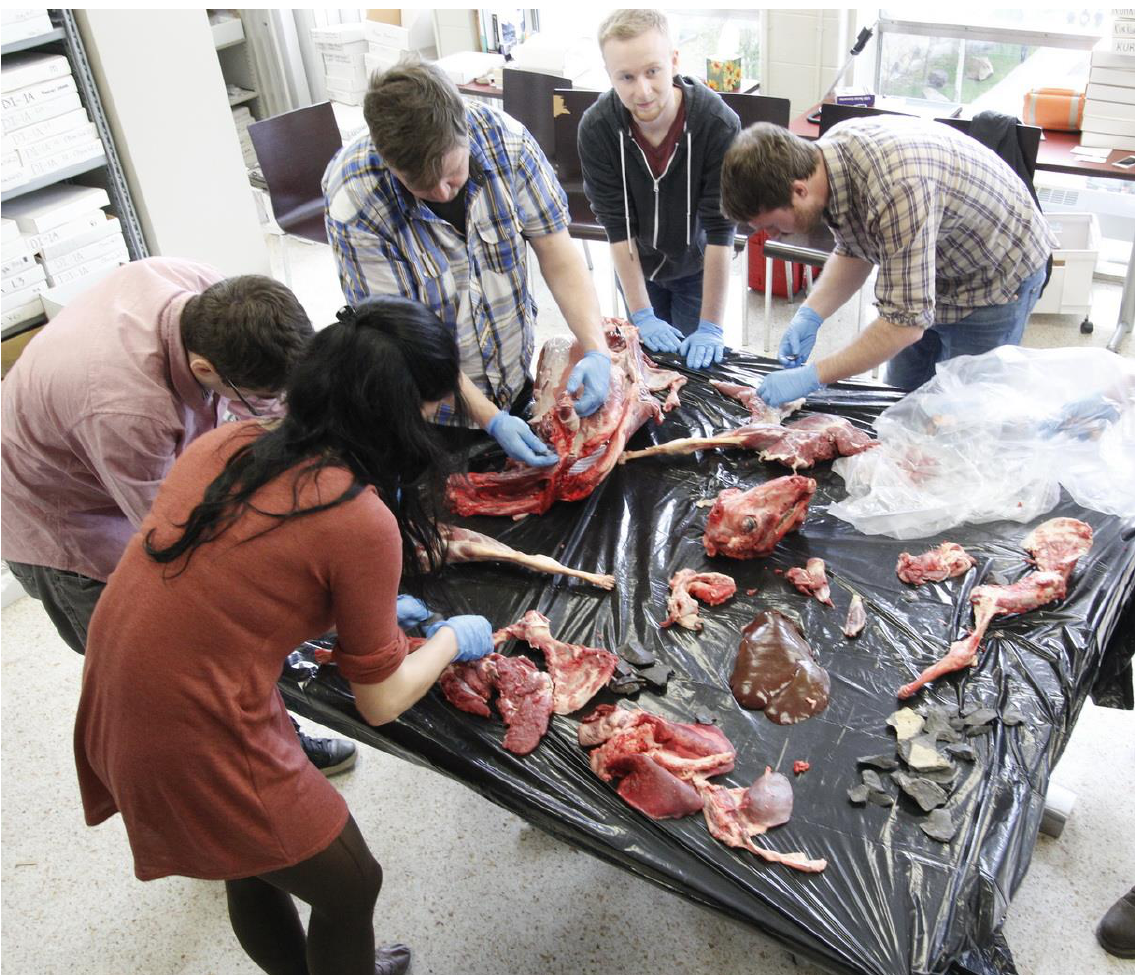
Figure 5. The food processing team sectioned and butchered the sheep in only a few hours. Each part of the animal was retained for food or a research